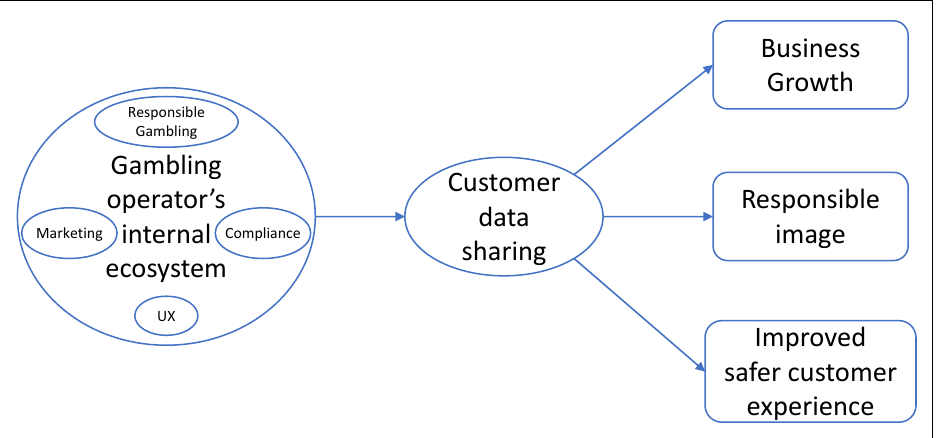
Figure 1. Data sharing as principle of responsible gambling